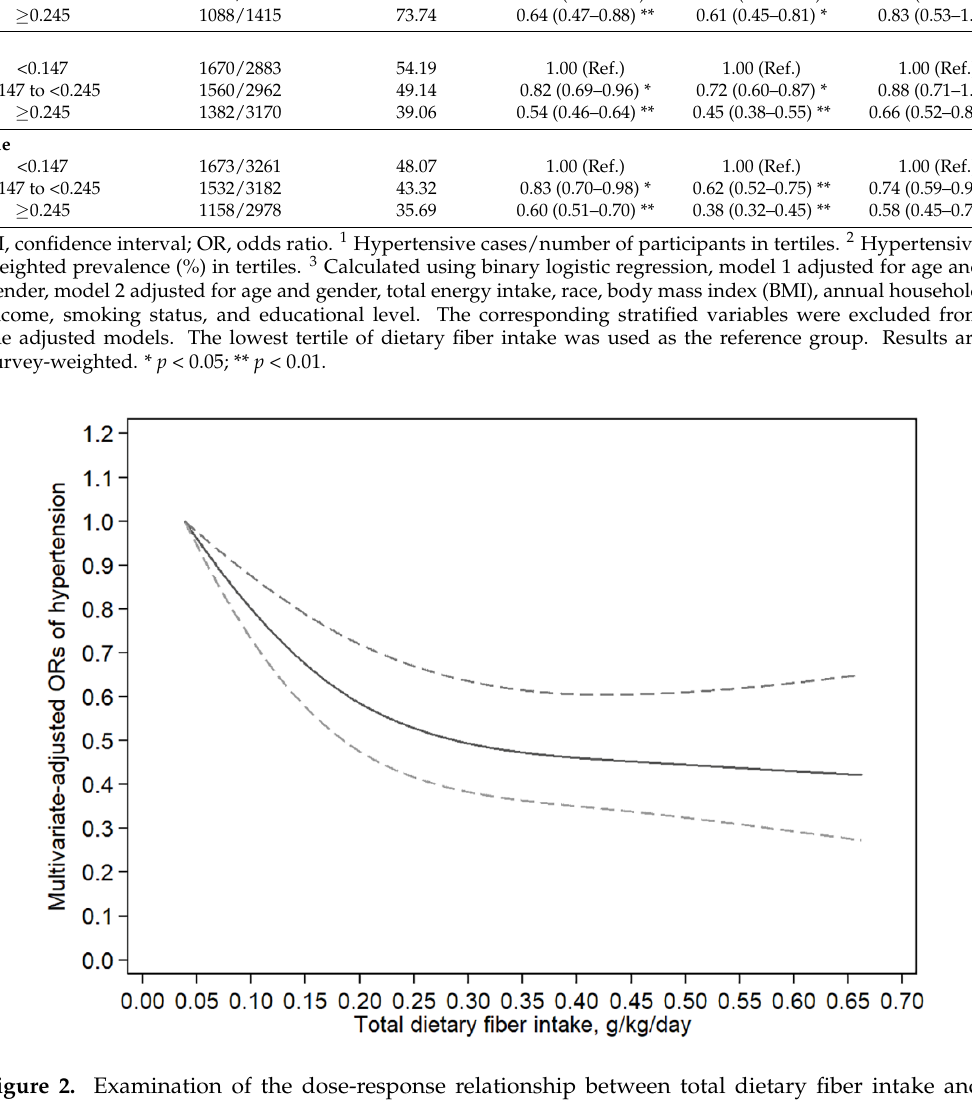
Figure 2. Examination of the dose-response relationship between total dietary fiber intake and the risk of hypertension by restricted cubic splines model. The lowest level of total fiber intake (0.071 g/kg/day) was used as the reference group. The restricted cubic splines model adjusted for age, gender, total energy intake, race, body mass index (BMI), annual household income, smoking status, and educational level. The solid line and dashed line represent the estimated ORs and the corresponding 95% confidence intervals, respectively. OR, odds ratio.